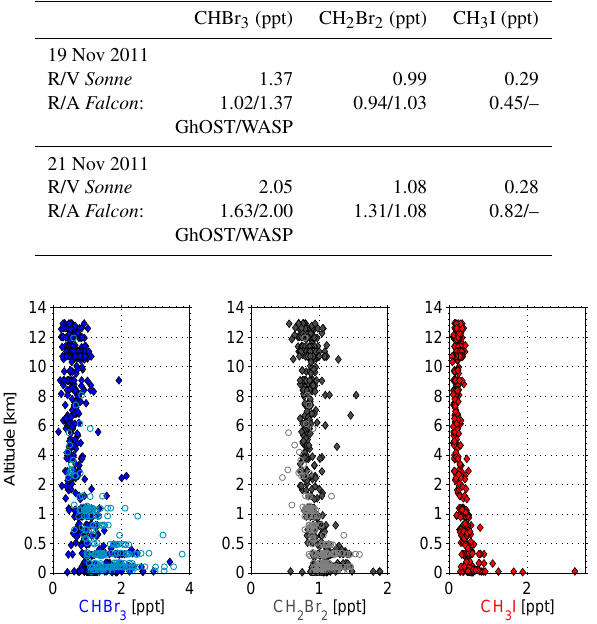
Figure 5. Vertical distribution CHBr 3 (blue), CH 2 Br 2 (grey) and CH 3 I (red) mixing ratios measured in situ by GhOST (diamonds) and with flasks by WASP (circles) on R/A Falcon . CH 3 I was only measured in situ by GhOST. The lower 2km are non-linear dis-